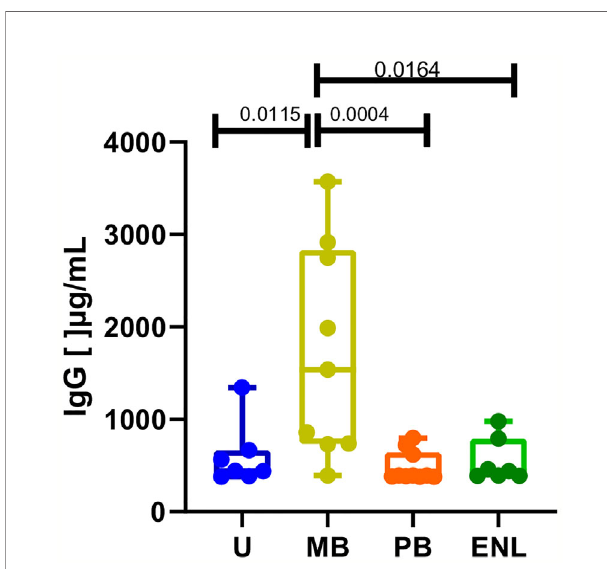
FIGURE 4 | Total IgG levels measured by ELISA in sera from uninfected individuals (U), paucibacillary patients (PB), multibacillary patients in type II reaction (ENL) or not (MB). Signi fi cant values were calculated by the Kruskal- Wallis test with Dunn ’ s multiple comparisons test. A p-value < 0.05 was considered statistically signi fi